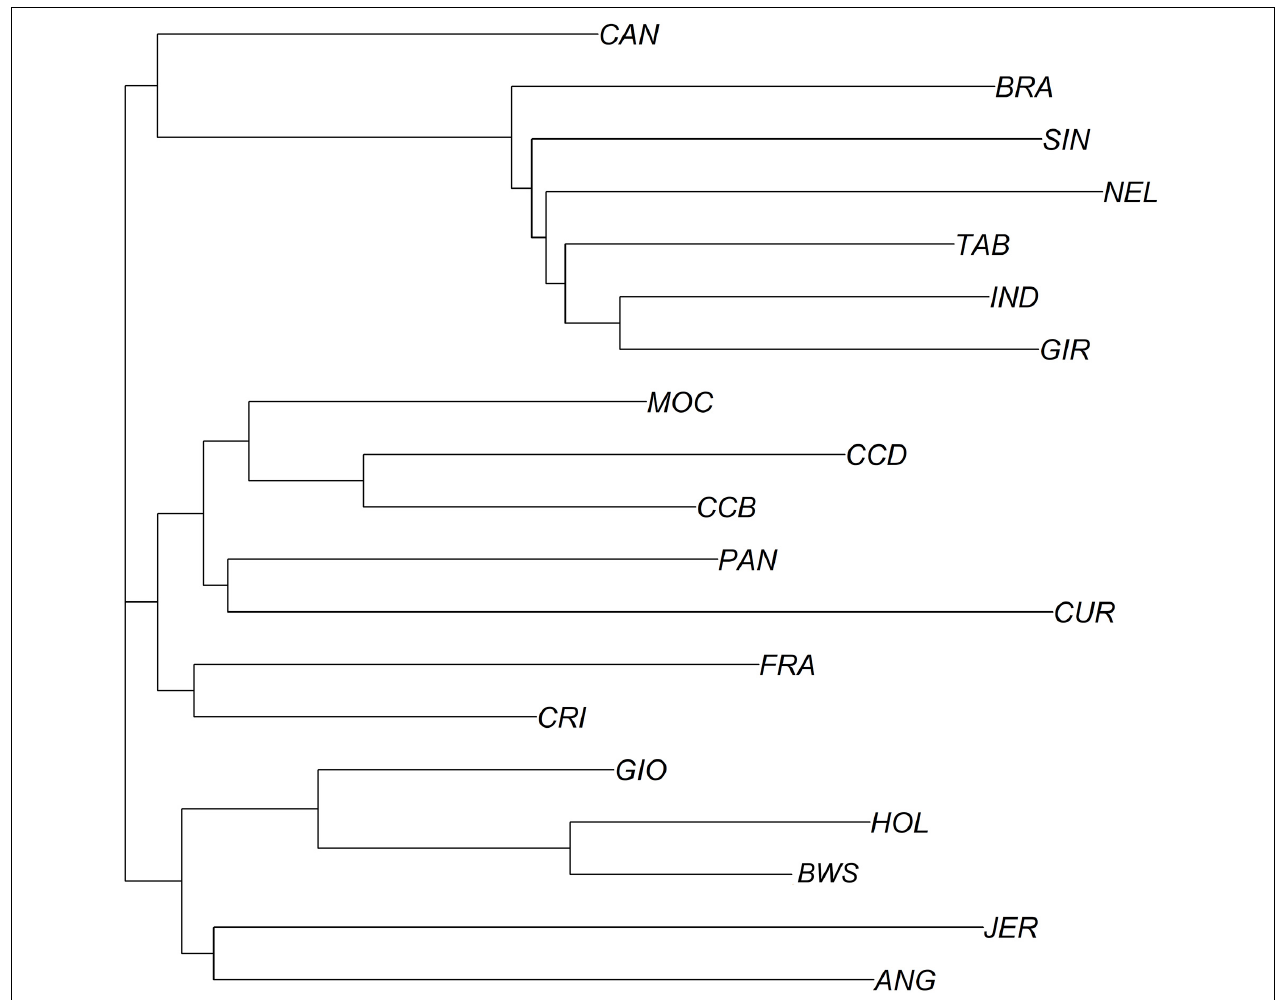
FIGURE 6 | Phylogenic tree showing relationships between 19 cattle breeds raised in Brazil. Phylogenetic tree constructed using a neighbor-joining approach using Euclidian genetic distance. Breeds are labeled as Canchim (CAN), Brahman (BRA), Sindhi (SIN), Nelore (NEL), Tabapuã (TAB), Indubrasil (IND), Gir (GIR), MochoNacional (MOC), Caracu Dairy (CCD), Caracu Beef (CCB), Pantaneiro (PAN), CurraleiroPé-Duro (CUR), CriouloLageano do RS (FRA), CriouloLageano (CRI), Girolando (GIO), Holstein (HOL), Brown Swiss (BWS), Jersey (JER), Angus